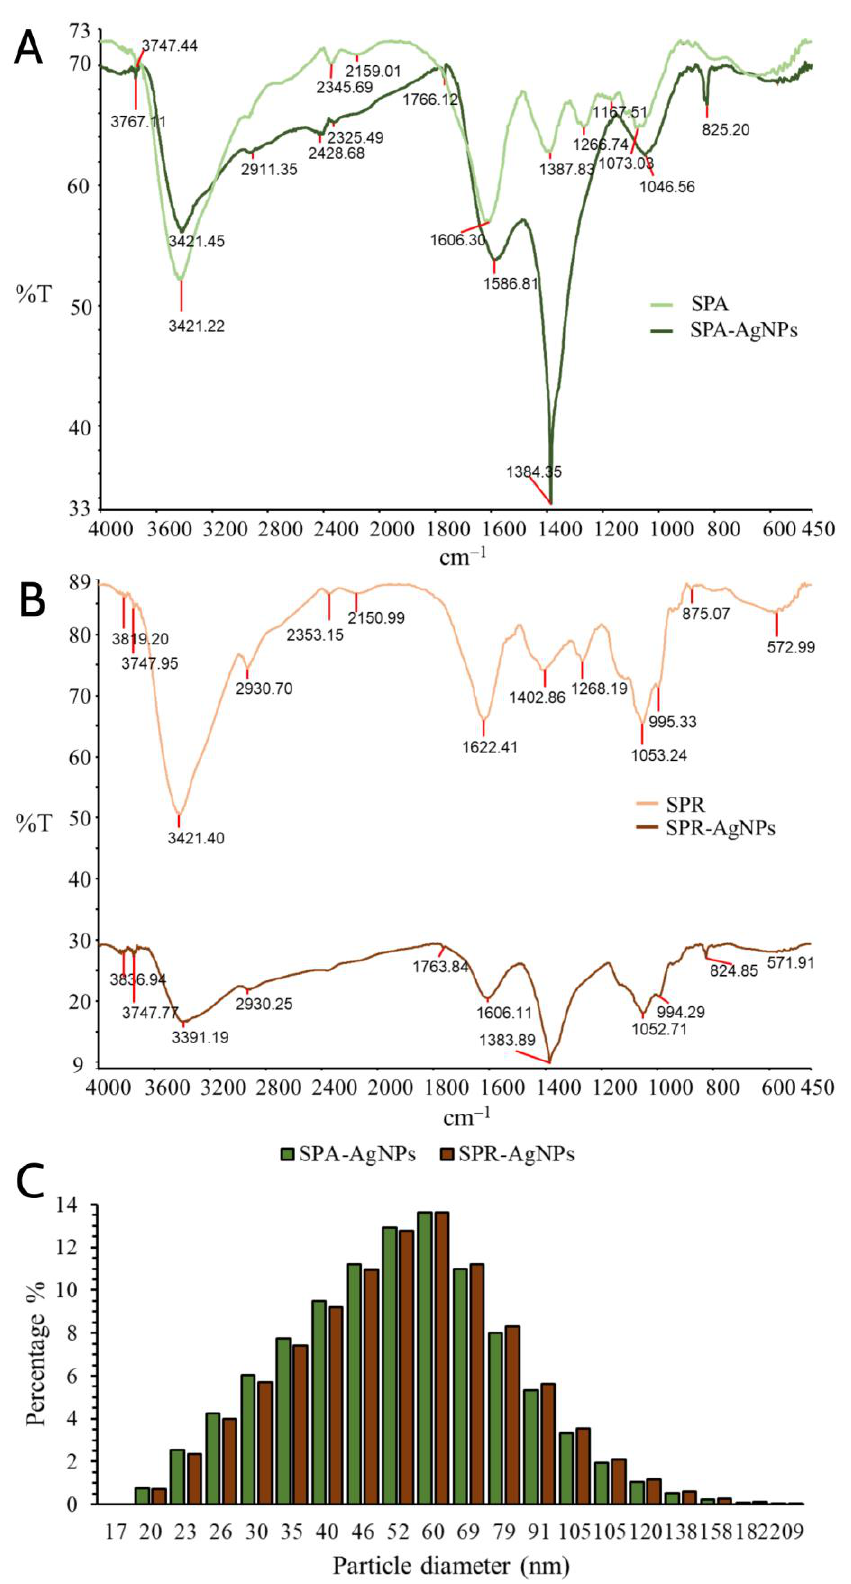
Figure 5. FTIR spectra of the S. pratensis aerial part ( A ) and root ( B ) extracts and corresponding AgNPs. ( C ) Size distribution of SPA-AgNPs and SPR-AgNPs by DLS analysis.